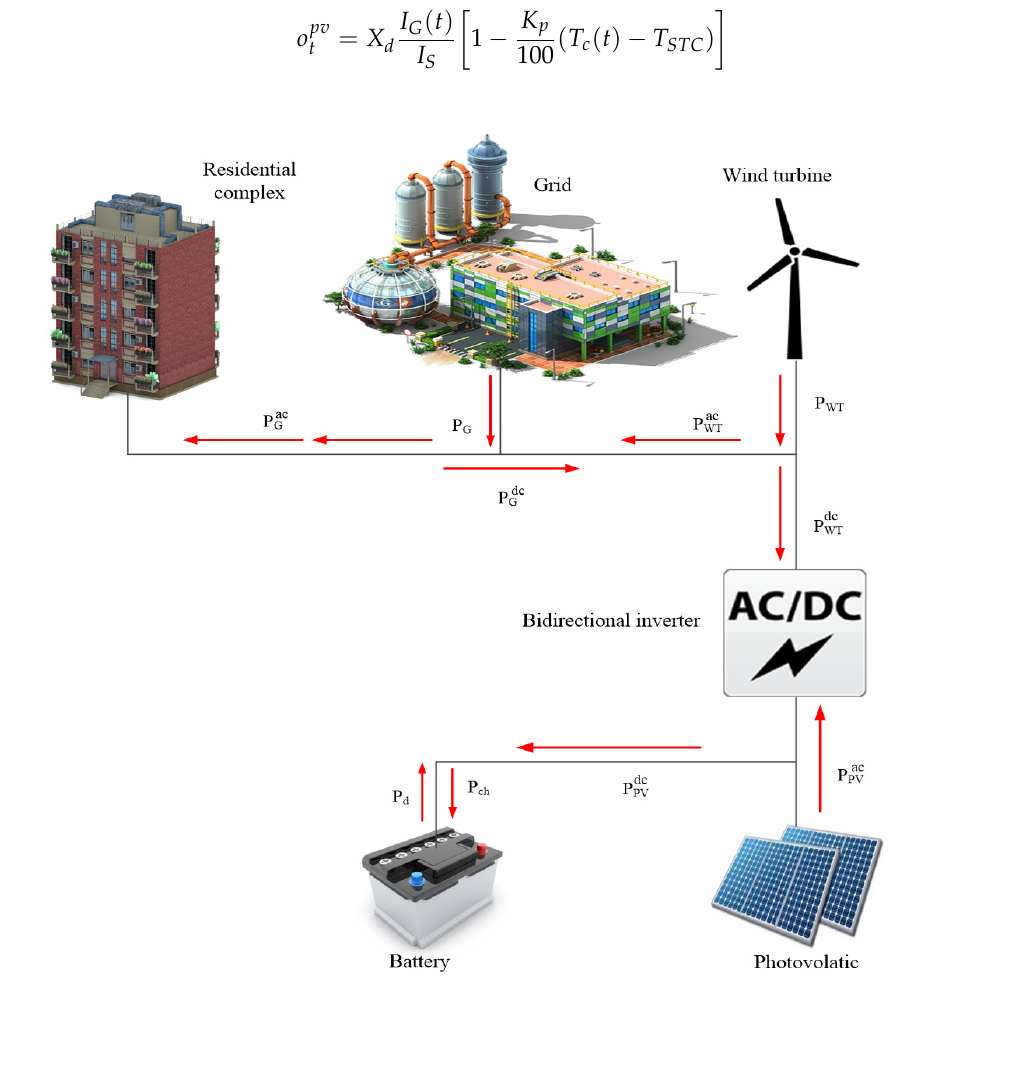
Figure 7. Power flow of renewable energy sources (RESs) in the proposed